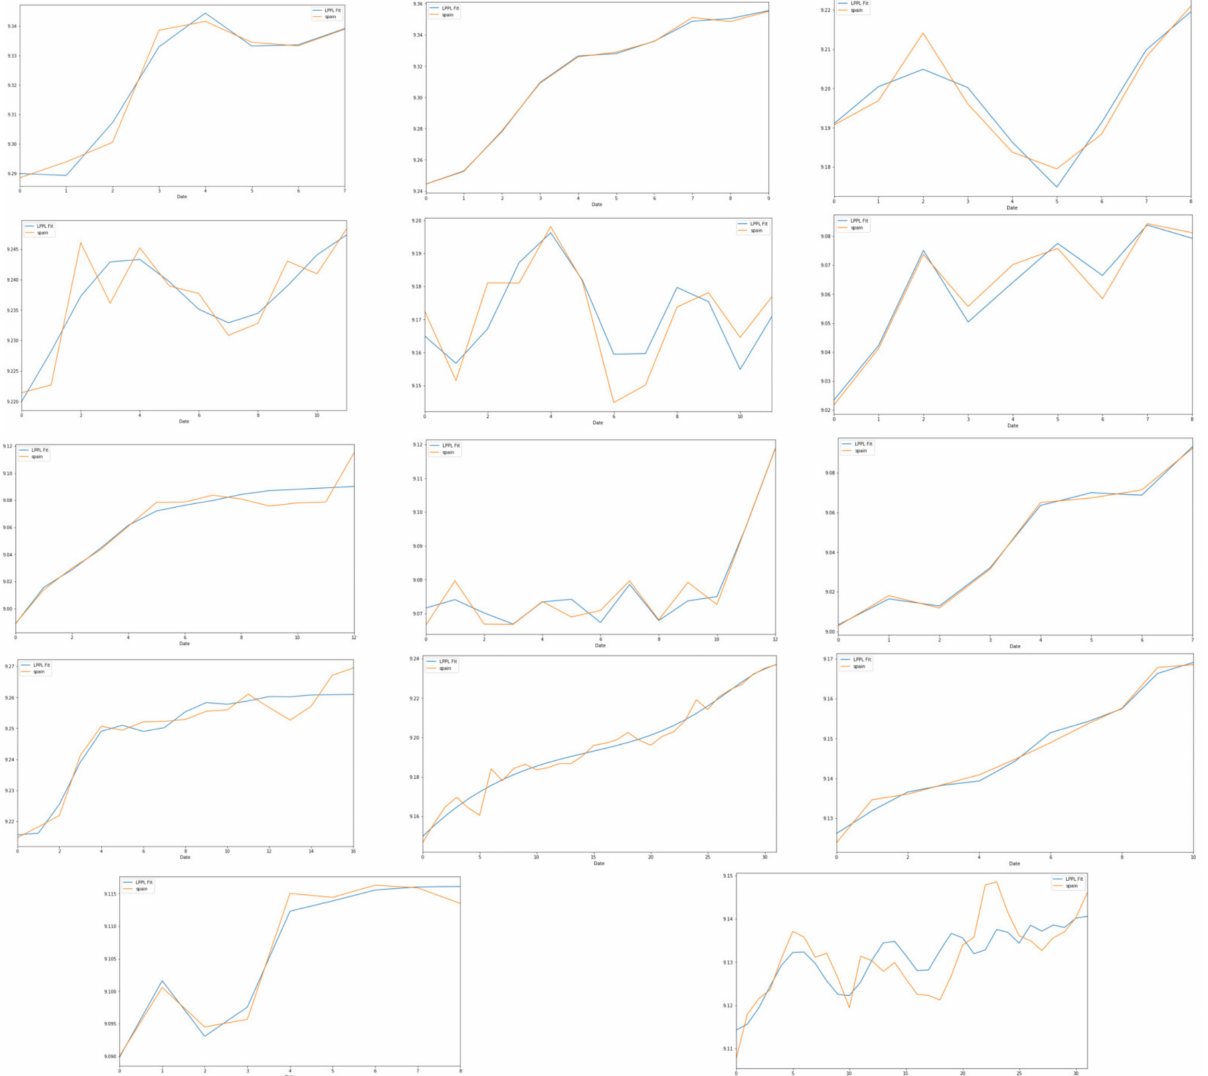
Figure A5. LPPL Signatures in the Spanish Stock Exchange (IBEX 35) 19 January 2015 to 17 February 2020. Log-periodic power law signatures in the Spanish Stock